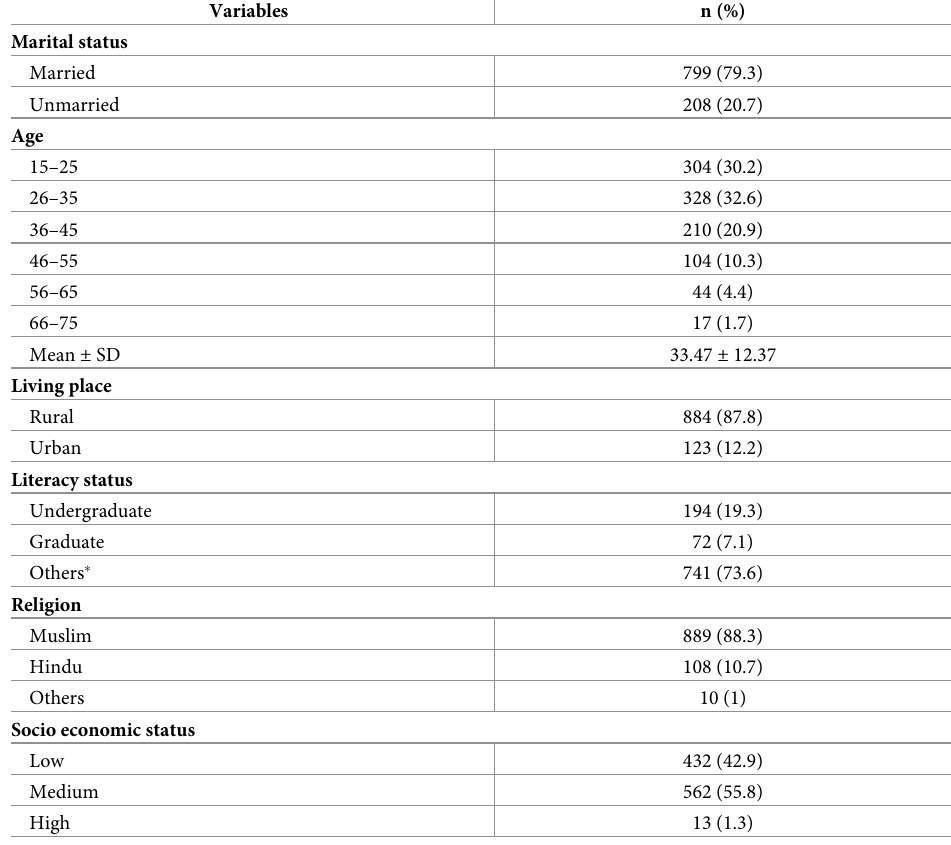
Table 1. Socio-demographic characteristics of female respondents (n =